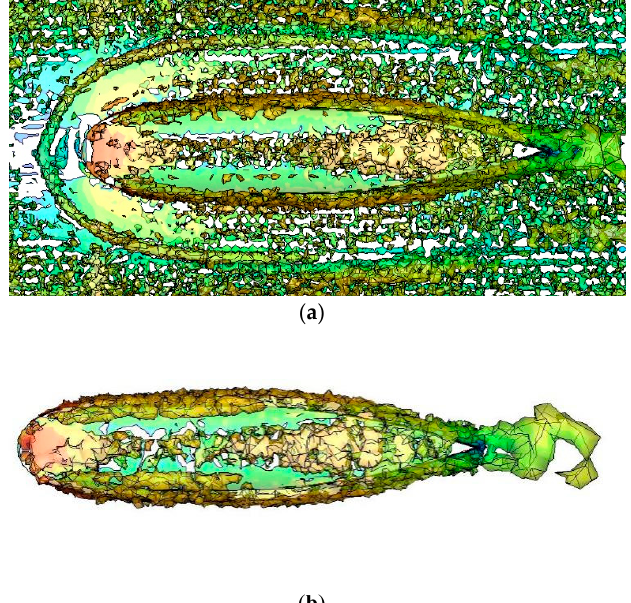
Figure 7. Flow phenomena of the two models: ( a ) the adopted model in this research; and ( b ) the isolated sail hull.